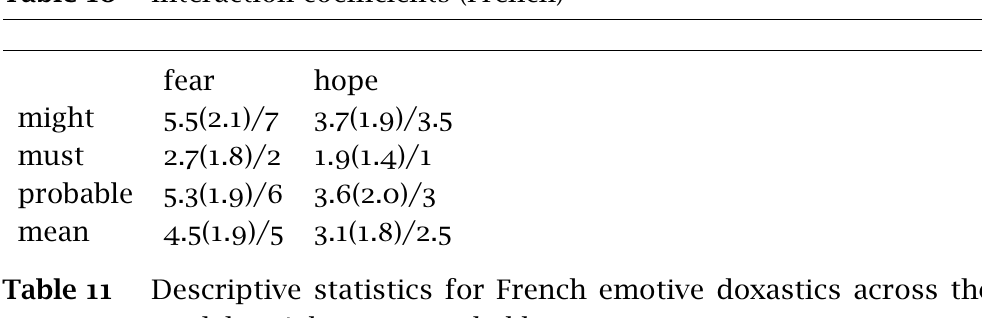
Descriptive statistics for French emotive doxastics across the modals might , must , probable